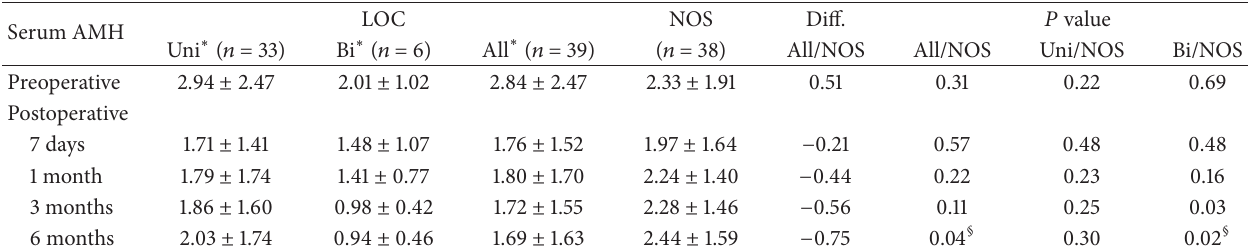
Table 2: Comparison of serum AMH level (ng/mL) between LOC and NOS